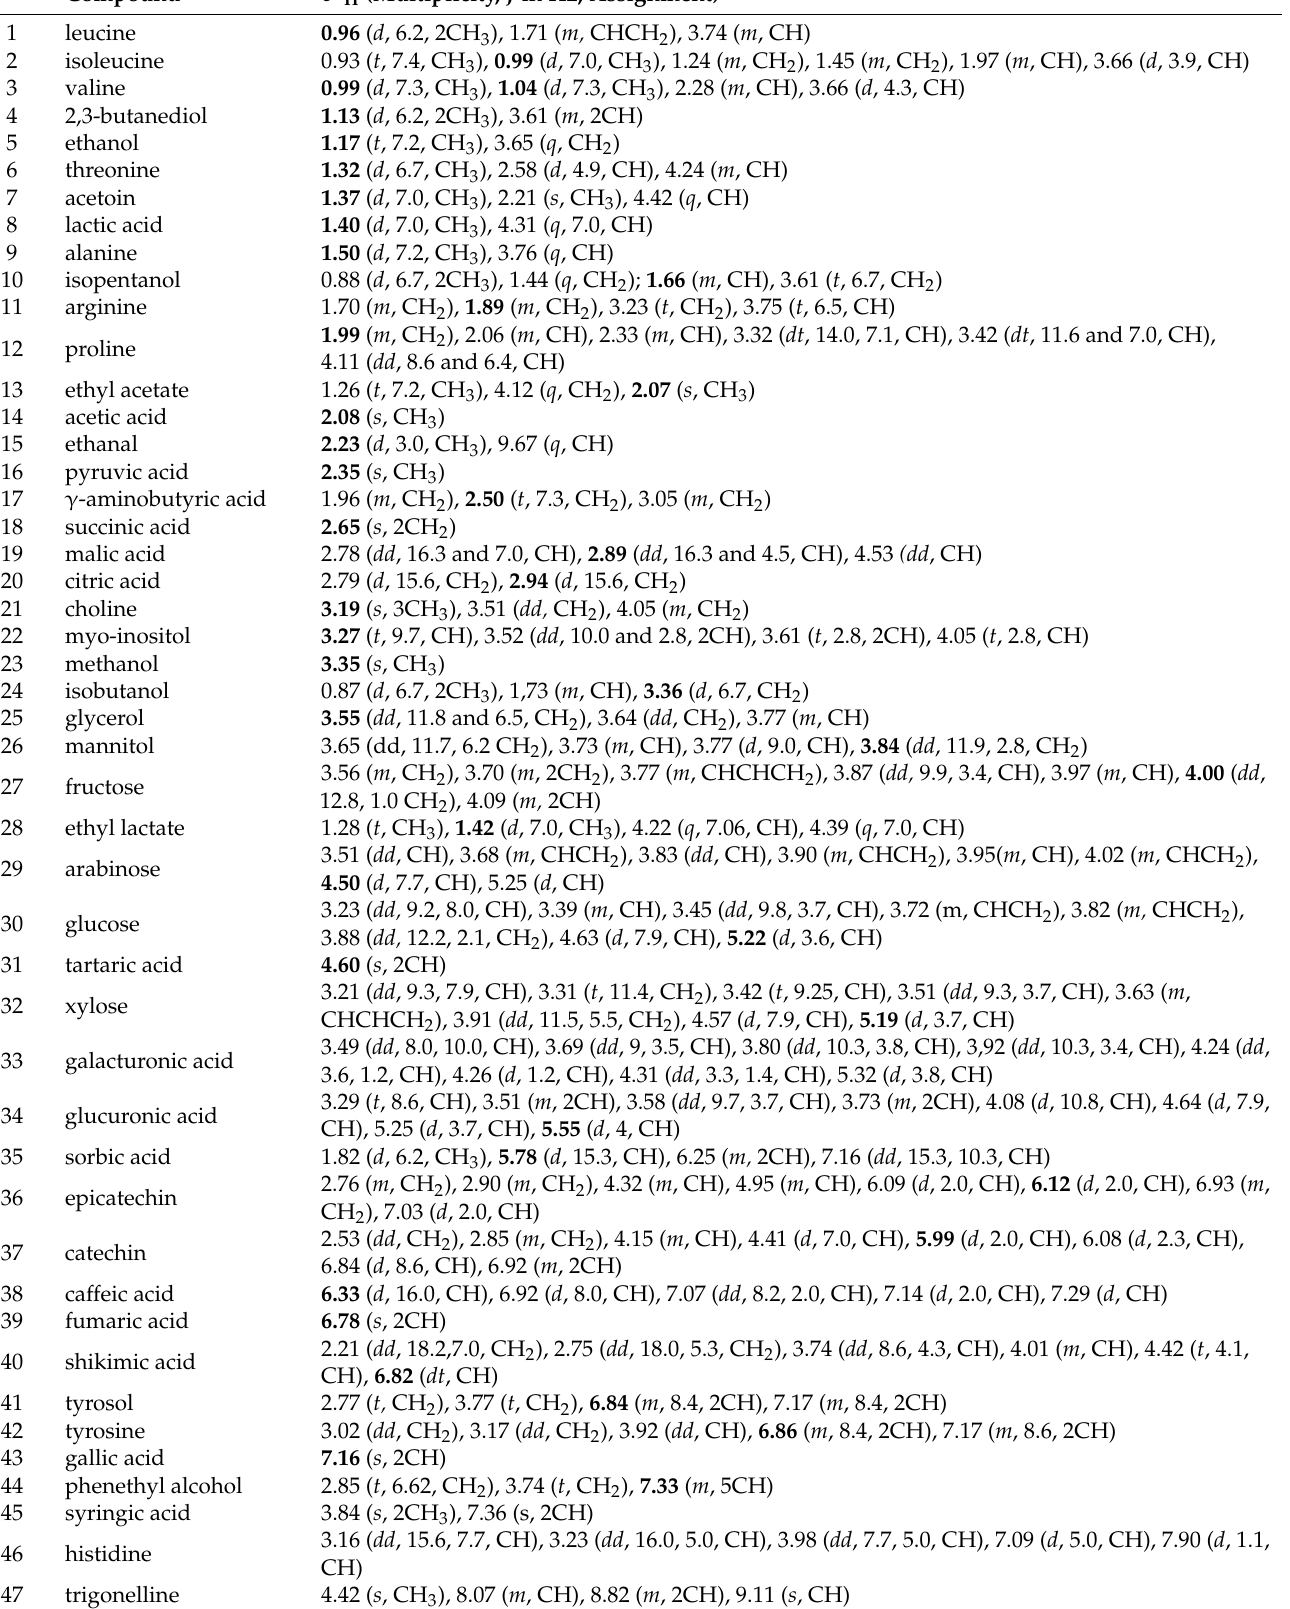
Table 1. Chemical shifts and coupling constants used for compound identification. The signals chosen for quantitation are in